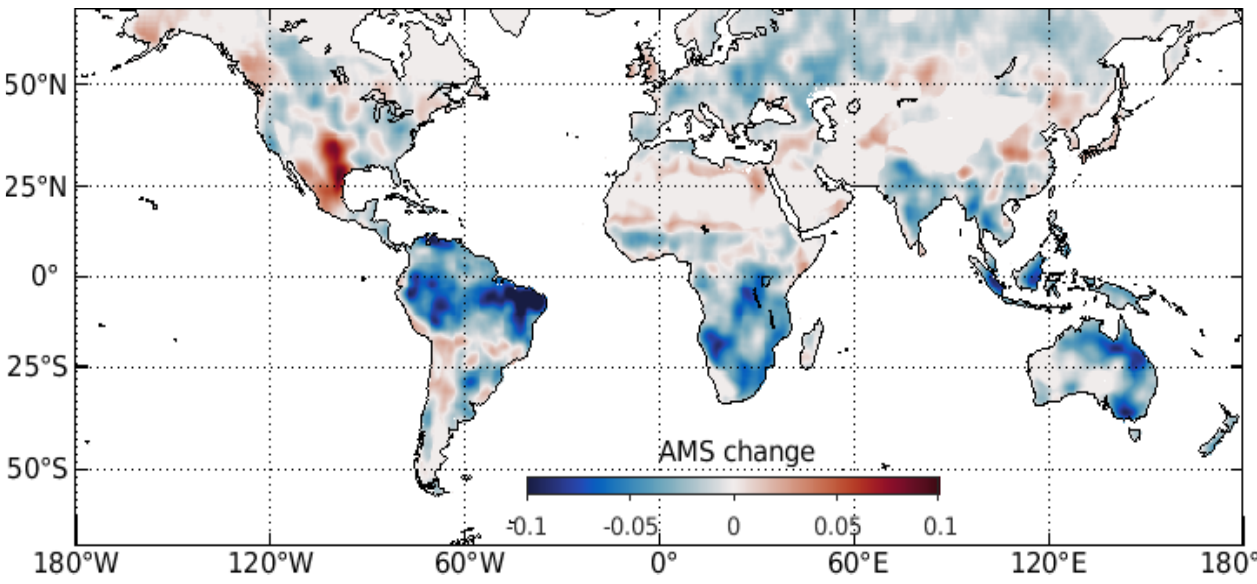
Figure 3. Difference of annual mean SIF (AMS) between 2011 and 2015, calculated as (AMS 2015 – AMS 2011 ), highlighting the dramatic changes in SIF between the 2015 El Niño and 2011 La Niña. Unit: mW m − 2 sr − 1 nm − 1.